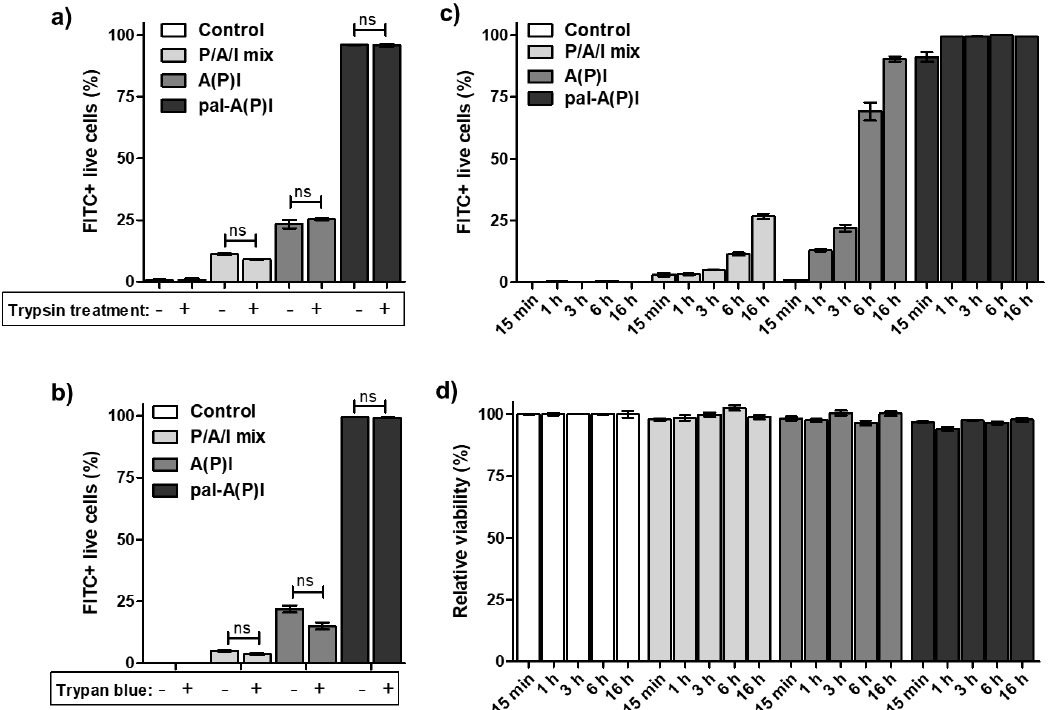
Figure 3. Detailed study on the cellular uptake by antigen presenting cells and the time course of internalization. Fluorescence intensity of compound treated cells was analyzed by flow cytometry ( a ) with or without trypsinization, and ( b ) in the presence or absence of trypan blue. No significant di ff erences were observed after eliminating the fluorescent signal from adsorbed peptides or conjugates. ( c ) To study the time course of internalization, di ff erent incubation periods (15 min, 1 h, 3 h, 6 h, and 16 h) were applied, and the intracellular fluorescence intensity was measured. ( d ) The viability of compound-treated cells was compared to untreated control cells, and relative viabilities are presented. The viability of the control cells was always > 85% (results are represented as mean ± SEM, n = 3).